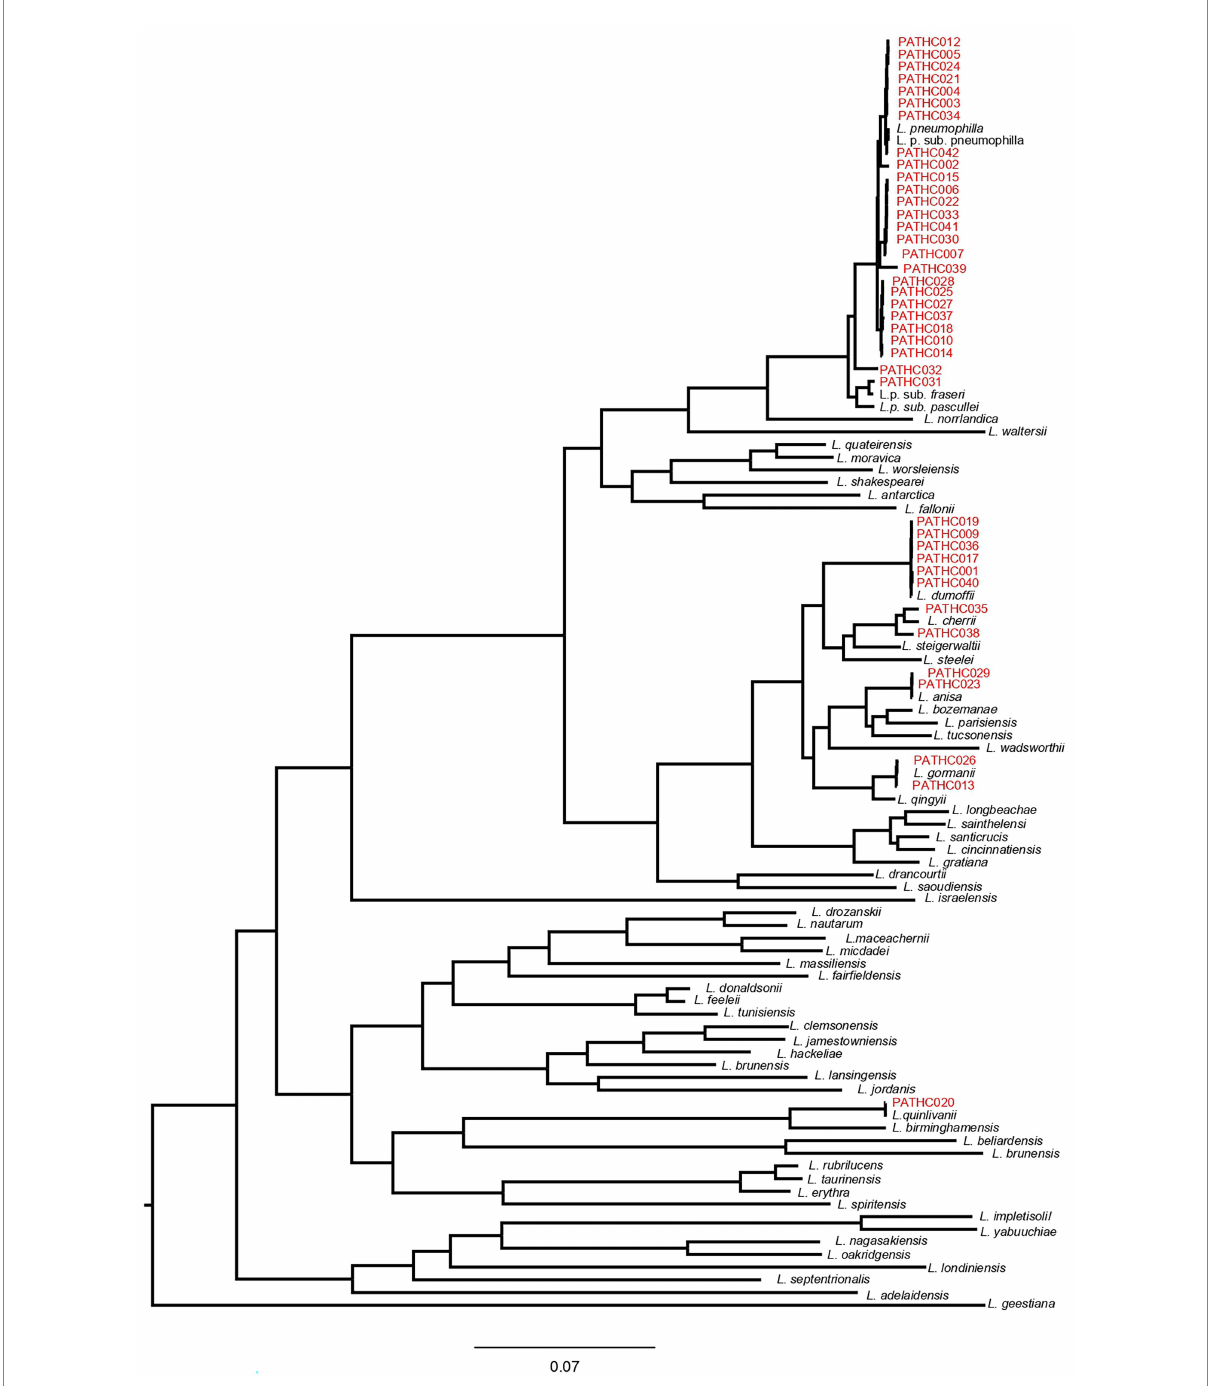
FIGURE 1 Core-genome dendrogram of Legionella type strains and the 39 newly sequenced Legionella isolates from this study. The core-genome was derived from 141 protein sequences encoded by single-copy genes. The tree was constructed, using Maximum Likelihood (ML) and the Approximate Likelihood-Ratio Test